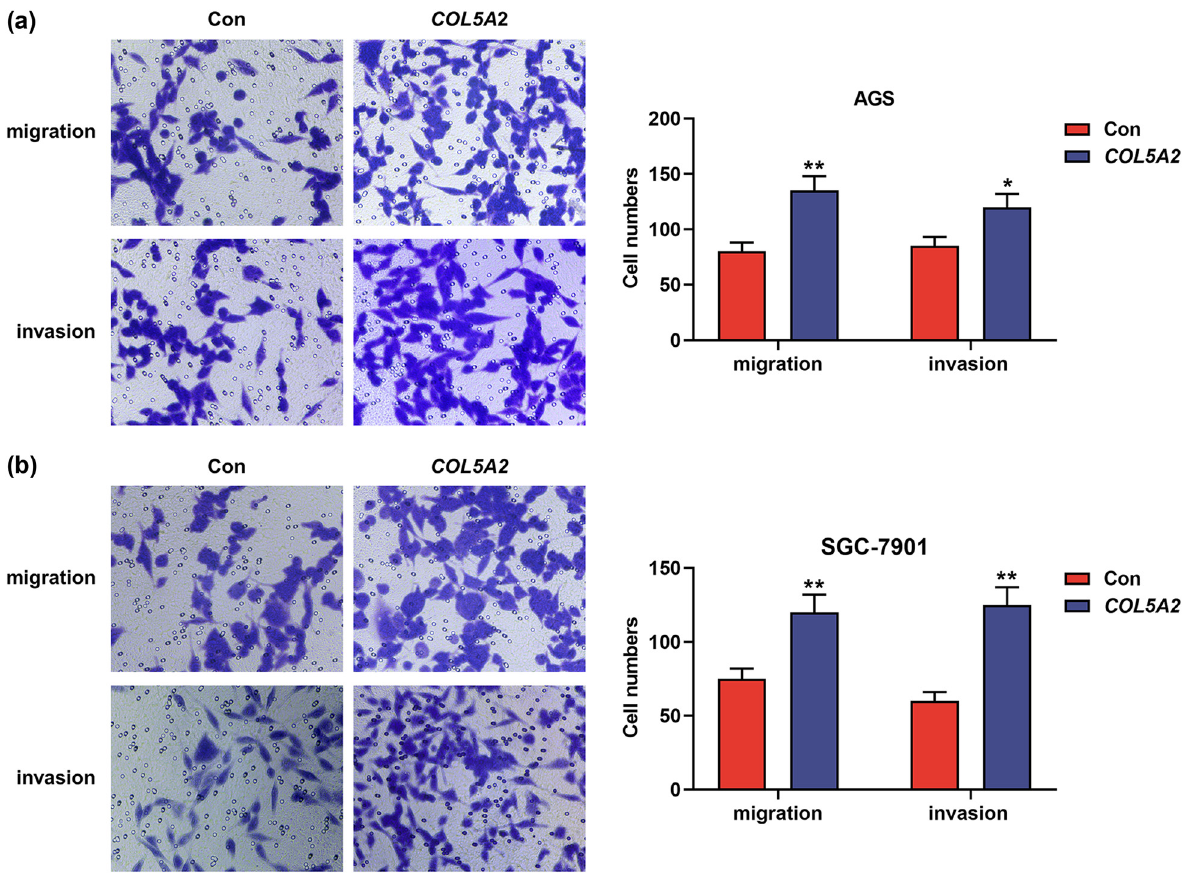
Figure 9: Overexpression of COL5A2 promoted the migration and invasion of GC cells. ( a and b ) After AGS and SGC - 7901 cells were transfected with COL5A2 overexpression plasmid, the numbers of migratory and invasive cells in AGS ( a ) and SGC - 7901 cells ( b ) were analyzed by transwell assay. Data from three independent experiments were exhibited by mean ± SD. * P < 0.05, ** P < 0.01 vs Con